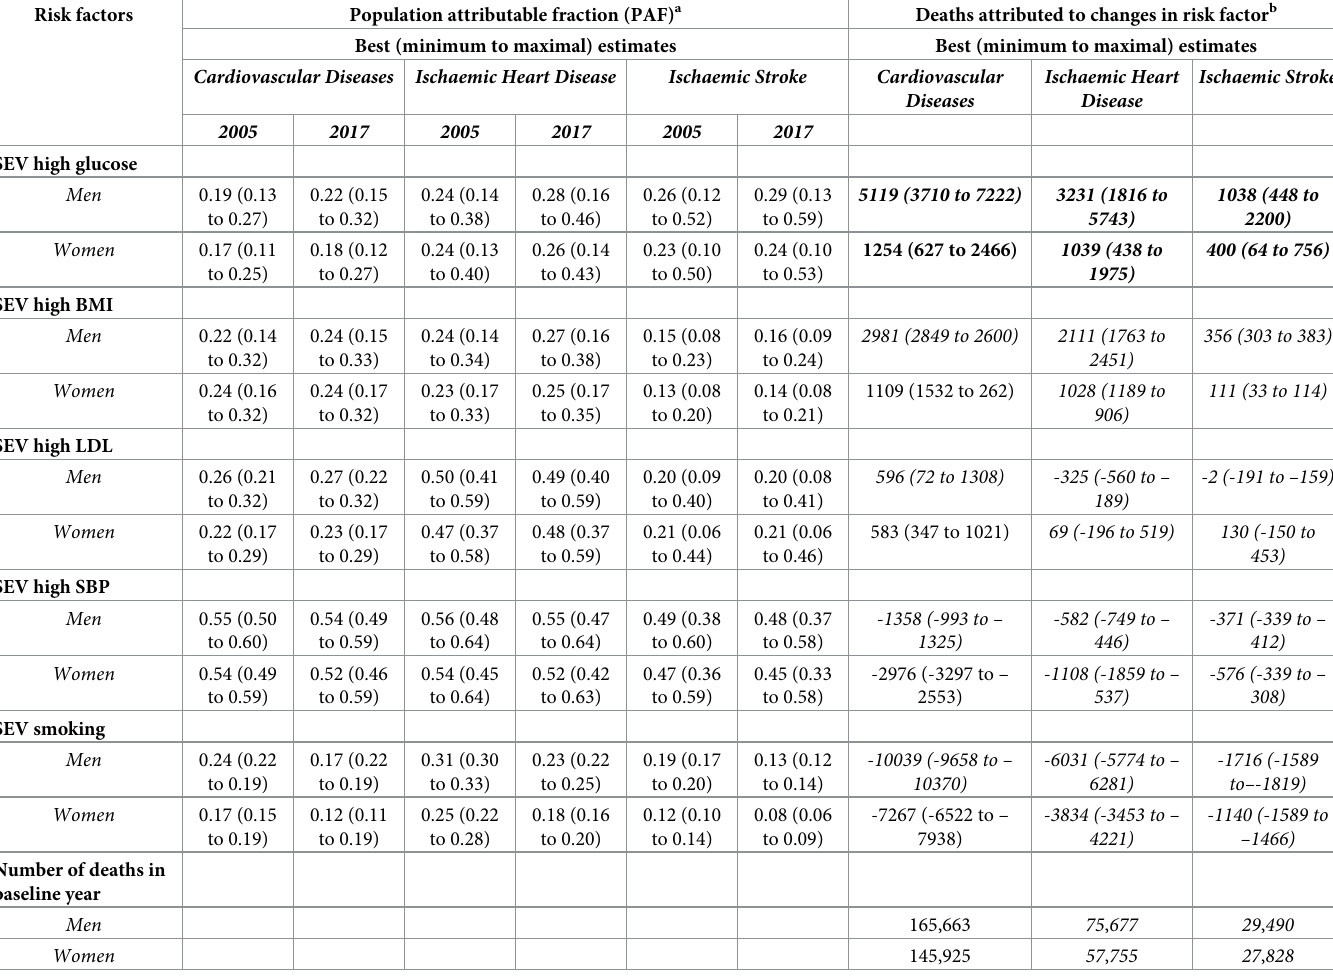
the prevalence of diabetes and the associations followed the same pattern as those observed for SEV for hyperglycaemia (S8 Table). Altogether, associations reported for hyperglycaemia in Fig 2 were robust and independent of socioeconomic variables and access to healthcare. Mean- while, associations reported for other risk factors, e.g. the negative association between BMI and CVD mortality (Fig 2), were inconsistent in the sensitivity analyses, suggesting they were due to autocorrelation or due to bias. Table 1. Deaths from cardiovascular diseases, ischaemic heart diseases and ischaemic stroke that were attributed to changes in risk factors in Brazilian states, 2005 to 2017. Risk